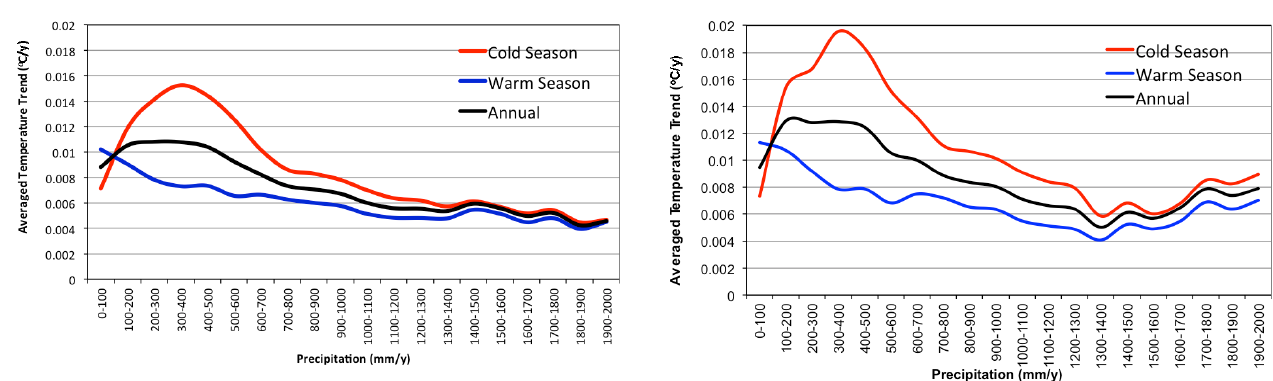
Fig. 5. Comparison of the regional averaged land surface linear tem- perature trend as function of climatological mean precipitation for annual, cold season and warm season of global. The precipitation interval is 100mmyr − 1 .